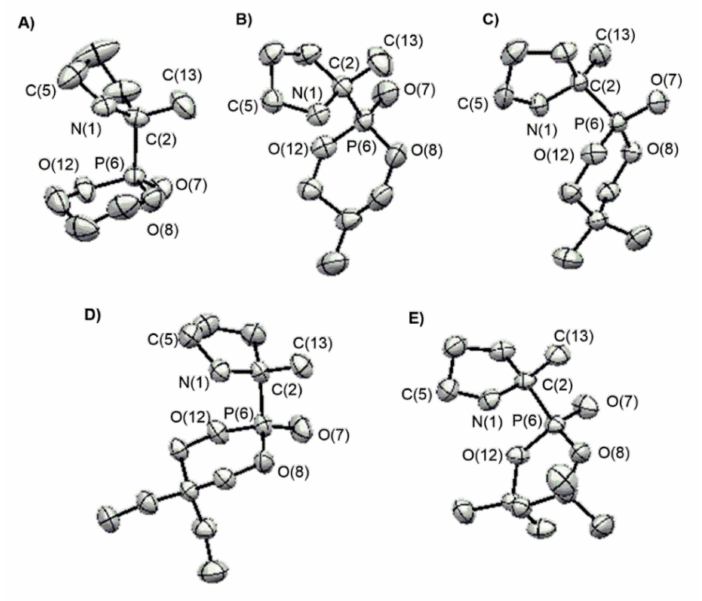
Figure 2. ORTEP drawings of CyDEPMPHs ( A ) 1b ; ( B ) trans - 1c ; ( C ) 1d ; ( D ) 1e ; ( E ) 1f showing the labeling of atoms (see also Table 1 heading) and their displacement ellipsoids at the 40% probability level. For clarity, H-atoms have been omitted.